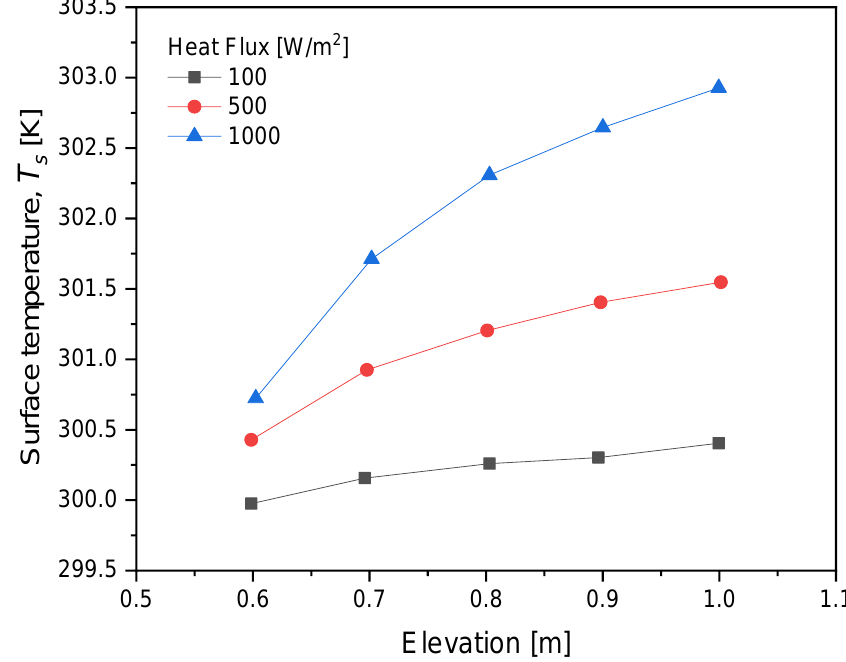
Figure 12. Influences of heat flux on surface temperature for a water inlet velocity of 1 m/s.